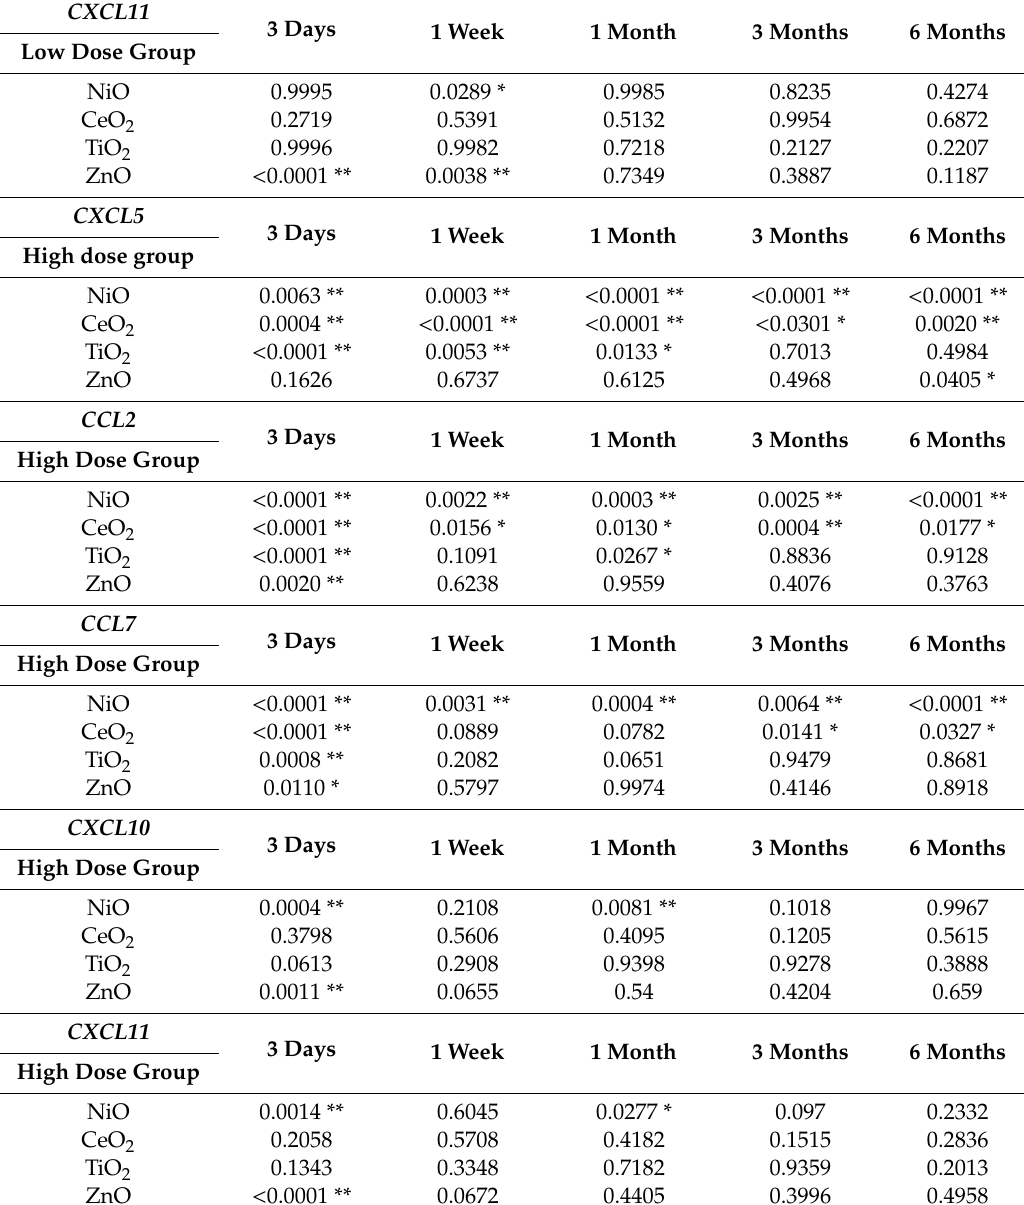
Table A2. p values of gene expression of 5 chemokines in lung exposed to